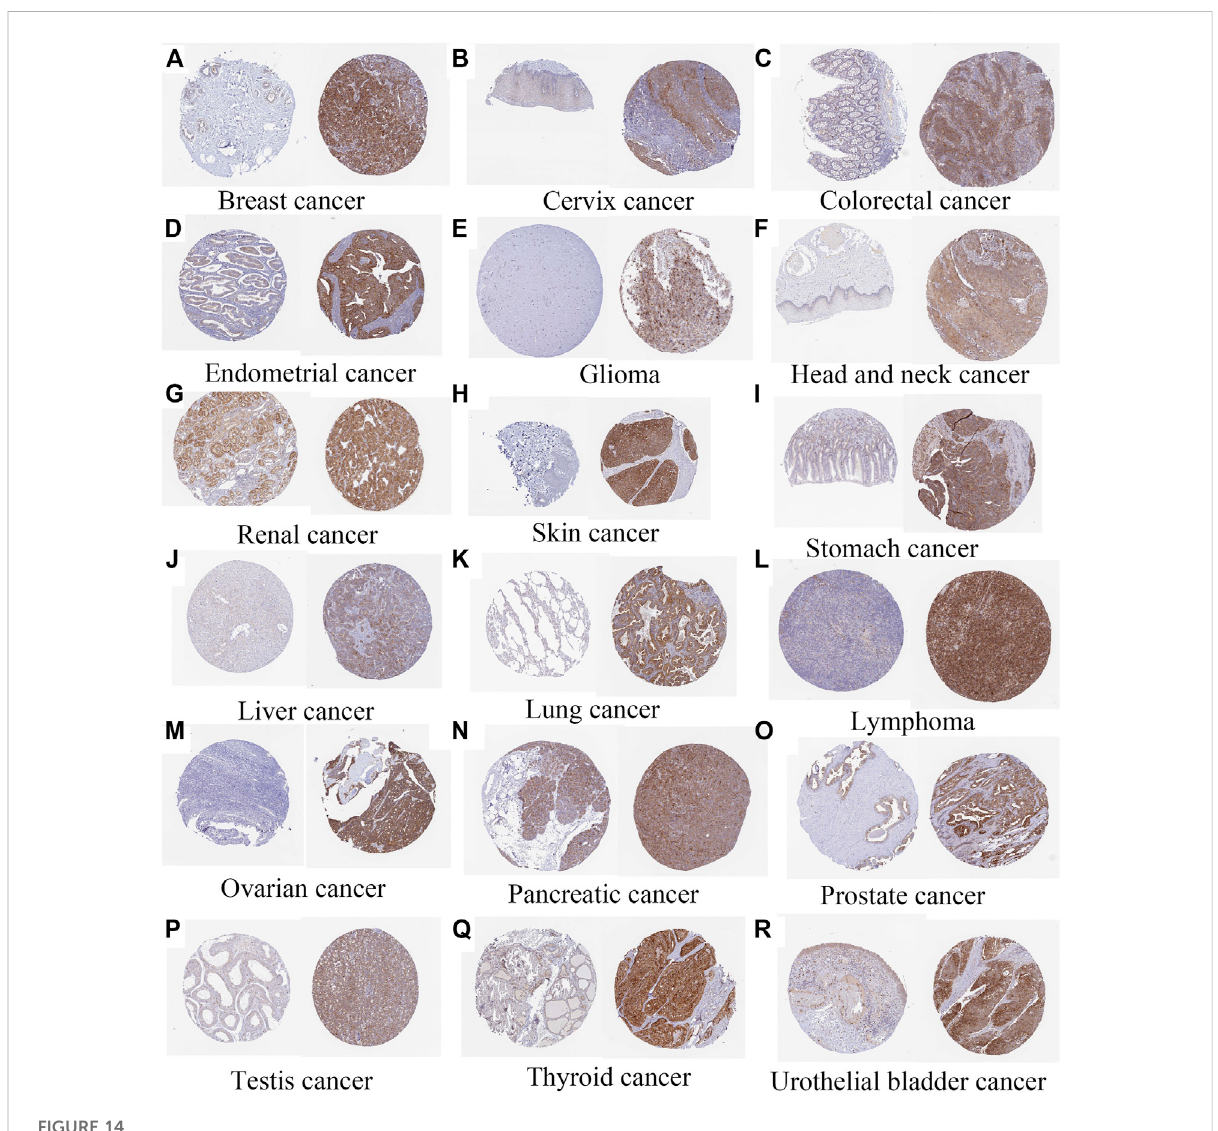
FIGURE 14 Immunohistochemistry of AGTRAP expression (normal tissue is on the left and tumor tissue is on the right) (A) Breast cancer (https://www. proteinatlas.org/ENSG00000177674-AGTRAP/pathology/breast+cancer). (B) Cervix cancer (https://www.proteinatlas.org/ENSG00000177674- AGTRAP/pathology/cervical+cancer). (C) Colorectal cancer (https://www.proteinatlas.org/ENSG00000177674-AGTRAP/pathology/ colorectal+cancer). (D) Endometrial cancer (https://www.proteinatlas.org/ENSG00000177674-AGTRAP/pathology/endometrial+cancer).